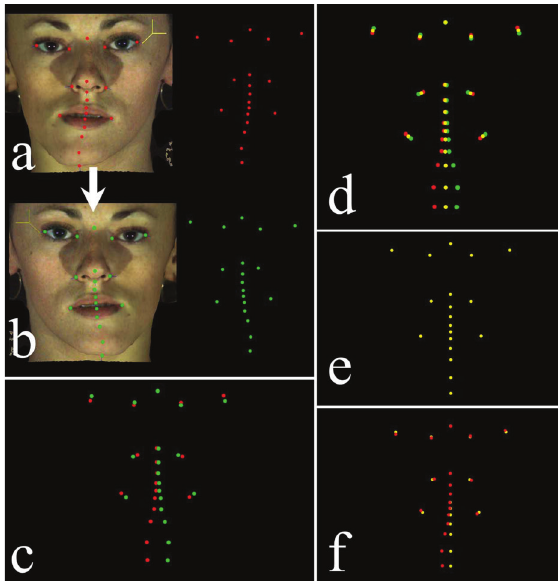
Figure 2. 3D facial asymmetry analysis based on landmarks. The original landmark configuration is shown in red (a). The mirrored configuration is shown in green (b). Both configurations are superimposed using partial Ordinary Procrustes Analysis (c) and the individual symmetrical landmark configuration is created and shown in yellow (d and e). Another superimposition is made between the original configuration and the individual symmetrical configuration (f), followed by calculating the squared Euclidean distances between pairs of homologous landmarks. (Reproduced from Hajeer MY, Ayoub AF, Millett DT. Three-dimensional assessment of facial soft-tissue asymmetry before and after orthognathic surgery. Br J Oral Maxillofac Surg 2004;42:396-404. With permission from Elsevier Ltd.)